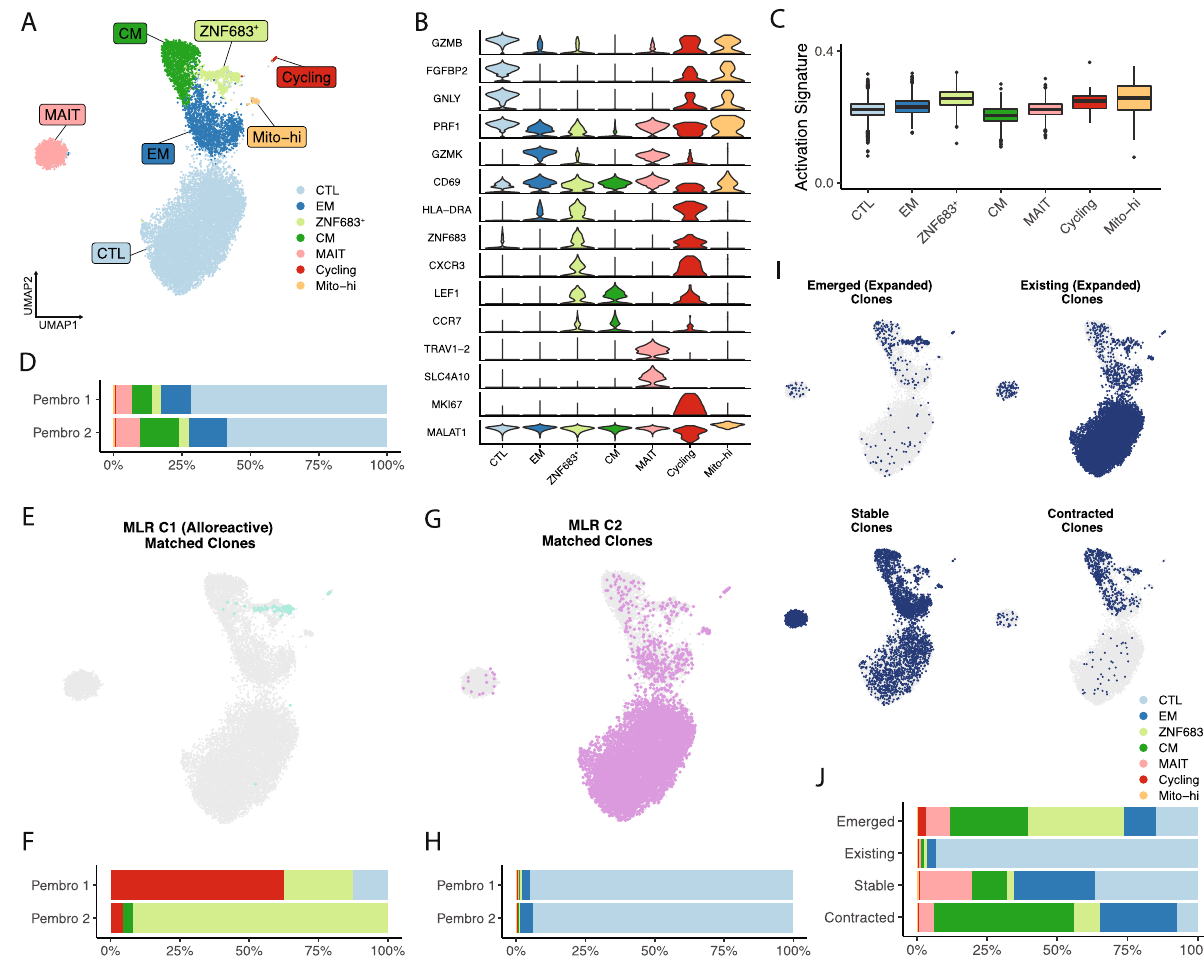
Fig.4|Decipheringthephenotypesofalloreactiveclonesintheblood.A UMAP clustering of non-naive CD8 + T cells isolated from post-pembrolizumab blood samples. B Violinplotofcluster-de fi ningmarkers. C Boxplotofactivationsignature acrossclusters. D Barplotofclusterproportionsacrosstimepoints. E UMAPofMLR C1 matching clones (green dots). F Bar plot of the cluster distribution of MLR C1 matching clones across timepoints. G UMAP of MLR C2 matching clones (purple